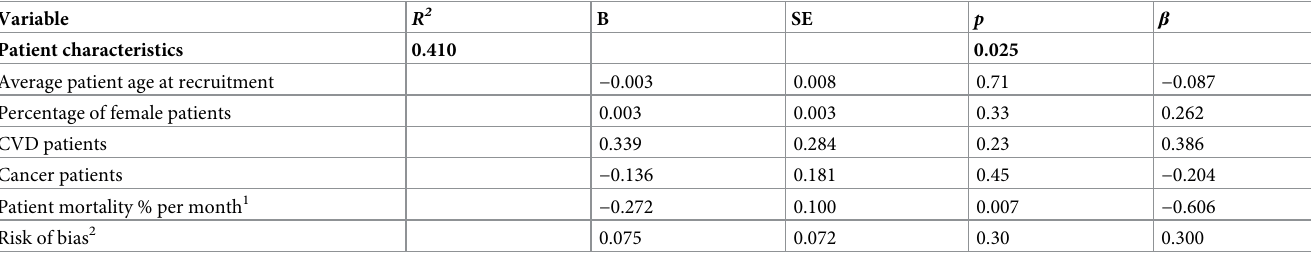
Table 4. Random effects meta-regression of HR estimates of patient characteristics on patient